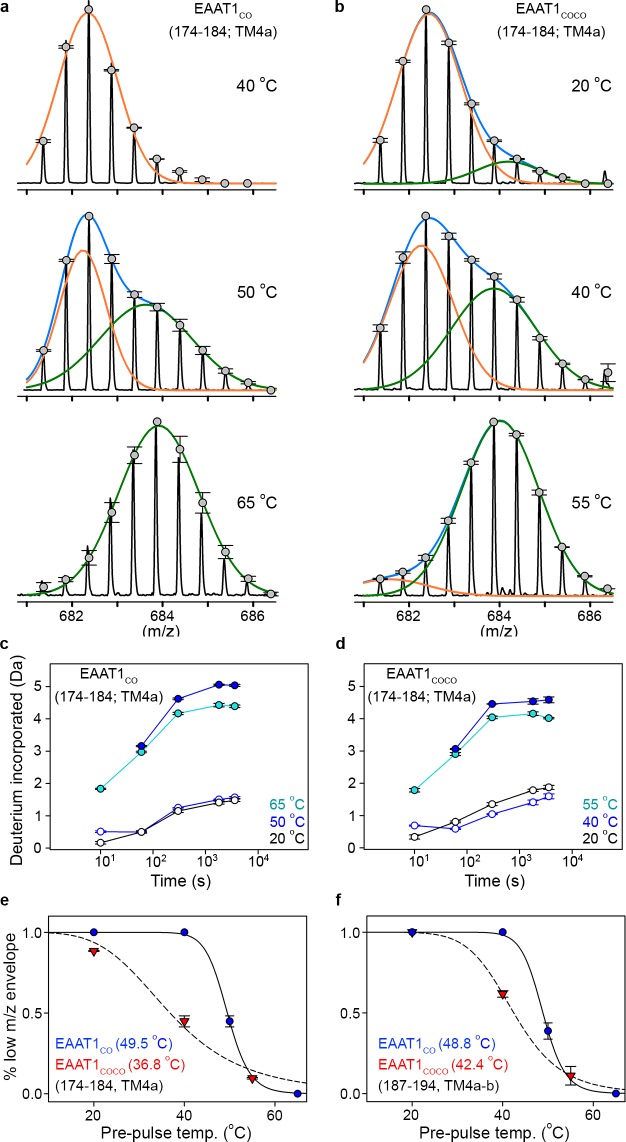
| Temperature-induced bimodal m/z envelopes at the trimeric interface.(a-b) m/z envelopes of an example peptide covering residues 174–184 of EAAT1CO (a) and EAAT1COCO (b), respectively, at different pre-pulse temperatures. Grey symbols represent the average of three experiments and error bars represent s.e.m, and are superimposed on the m/z spectrum of a representative experiment (black solid line). Blue solid lines represent fits of a double Gaussian equation to the data. The low-m/z (orange solid line) and high-m/z (green solid lines) components of such double-Gaussian fits are also shown. (c–d), HDX temporal course of peptide 174–184 of EAAT1CO (c) and EAAT1COCO (d) samples pre-heated at different temperatures. Deuterium incorporation values were calculated for the low-mass (blue open circles) and high-mass (blue solid circles) components of bimodal isotopic envelopes at the T50-SEC, as well as unimodal envelopes at high (cyan solid circles) and reference (black open circles) temperatures. Plots are an average of three independent experiments, and error bars represent s.e.m. (e–f), Pre-pulse temperature dependence of the low-m/z component in peptides 174–184 (e) and 187–194 (f) of EAAT1CO (blue), and EAAT1COCO (red). Solid and dashed lines indicate fits of a Hill-like equation to the data with T50-HDX-Bi values 49.5 ± 0.1°C and 36.8 ± 2°C, and H values −20 ± 3.1 and −4.4 ± 1 for peptide 174–184 in EAAT1CO and EAAT1COCO, respectively, as well as T50-HDX-Bi values 48.8 ± 0.2°C and 42.4 ± 0.1°C, and H values −20 ± 3.2 and −8 ± 0.1 for peptide 187–194 in EAAT1CO and EAAT1COCO, respectively. Plots depict an average of amplitudes measured at least at four different time points in three independent experiments, and error bars represent s.e.m.